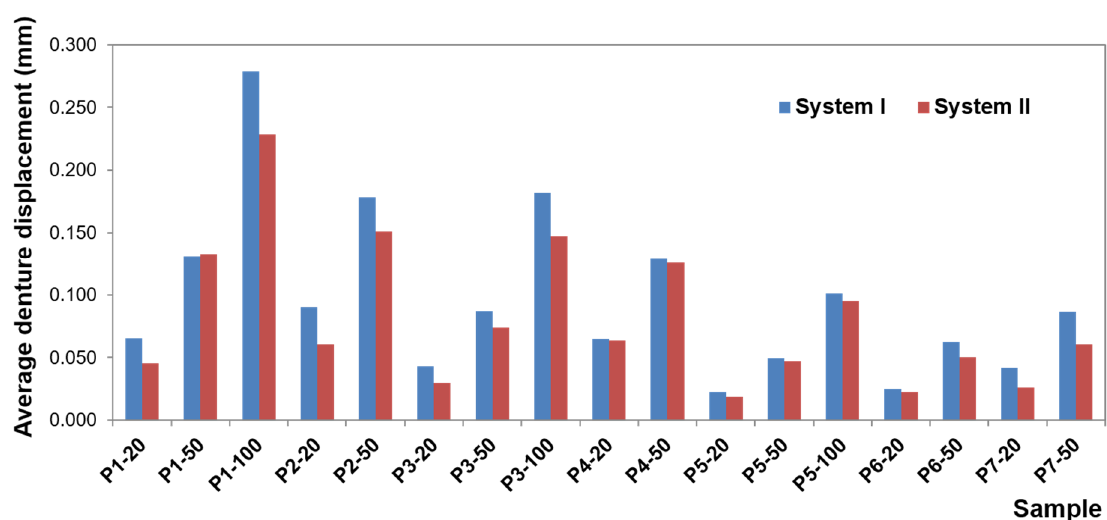
Figure 9. Average denture displacement in the first and second system.